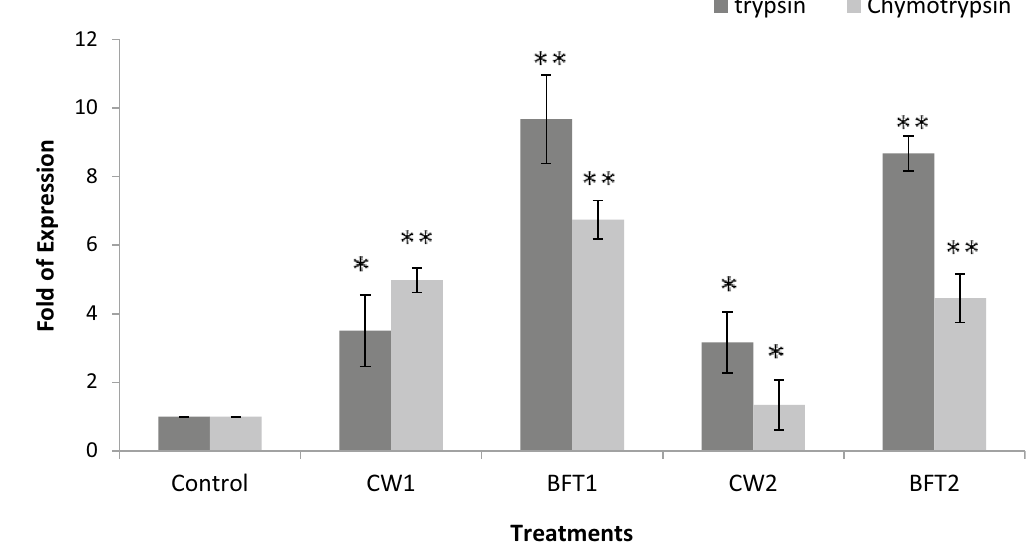
Figure 6. Expression level of trypsin and chymotrypsin of P. indicus cultured in different treatments and error bar showing standard deviation of three replicates. Significance between different groups ( P < 0.05) marked with asterisk .